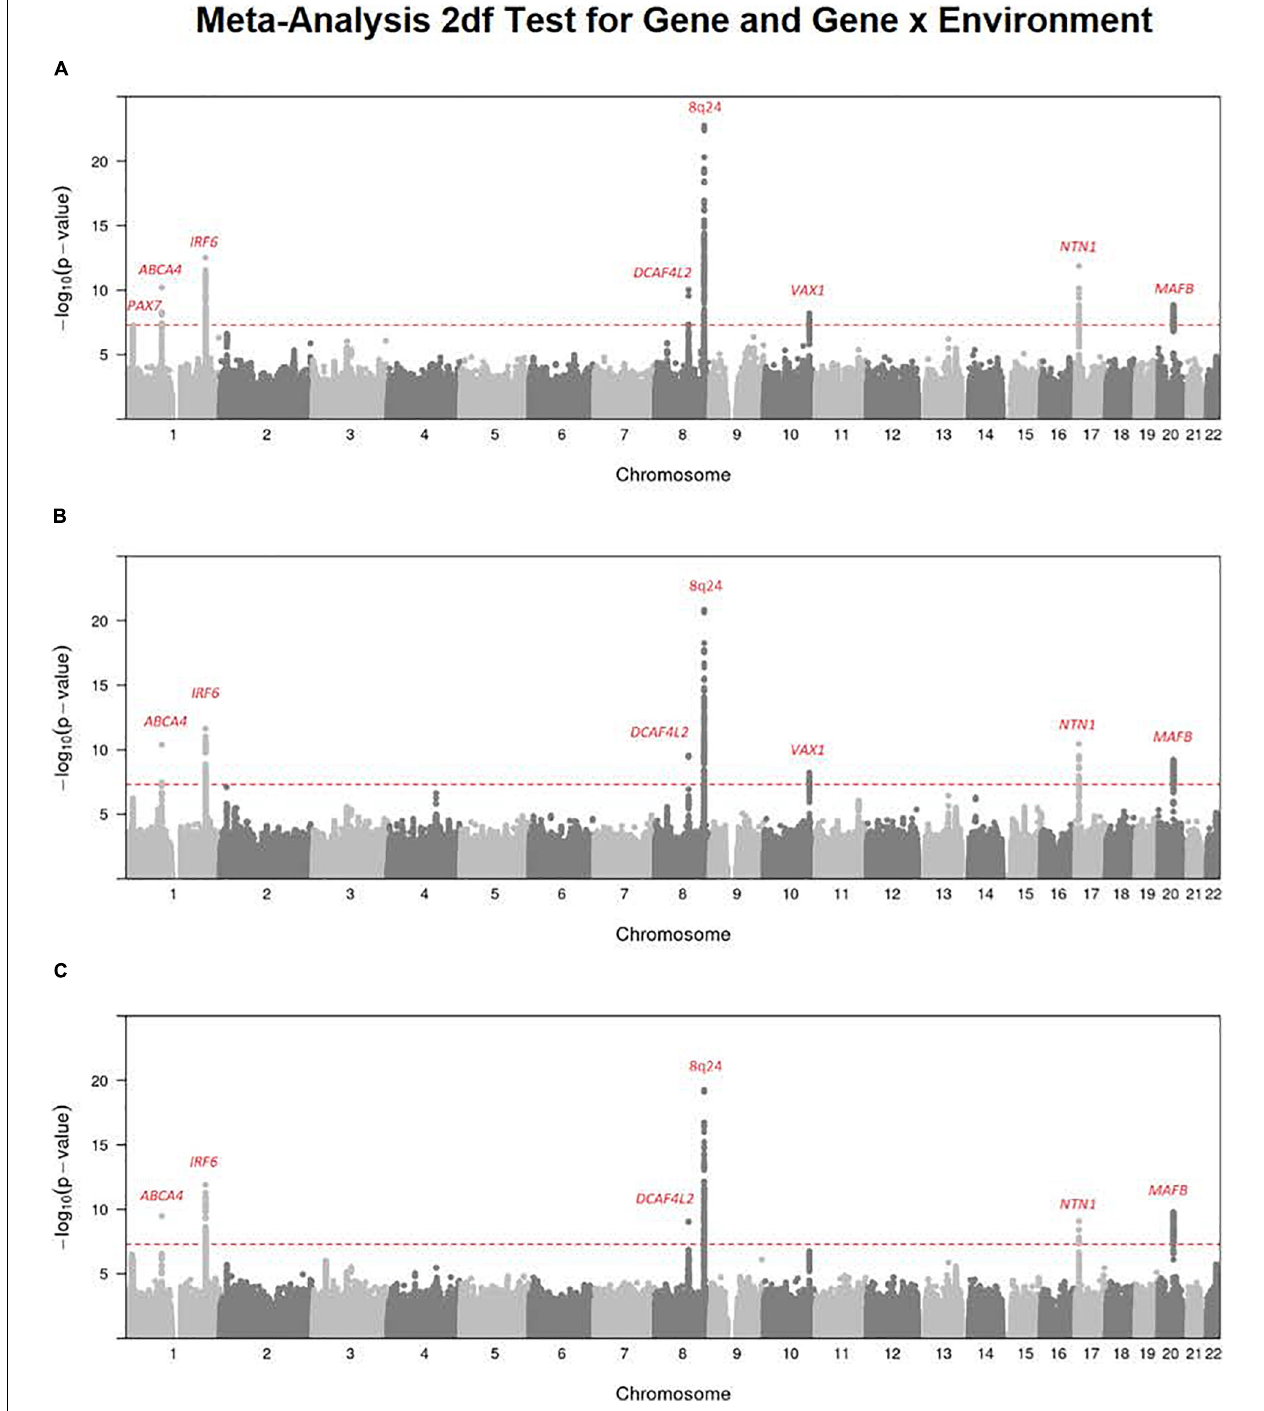
FIGURE 1 | Meta-analysis of the 2 df joint test for G and G × E interaction on all OFC case–parent trios across both the GENEVA and POFC studies. Numerous genes/regions show strong evidence of influencing risk to OFC largely through the main gene effect ( β G ) with very subtle differences that could be attributed to G × E interaction effect ( β GE ). Most of these strong signals represent recognized risk genes for CL/P. (A) Meta-analysis of 2 df test for G and G × Smoking interaction. (B) Meta-analysis of the 2 df test for G and G × Alcohol interaction. (C) Meta-analysis of the 2 df test for G and G × Vitamin interaction. The red dashed line represents the conventional threshold for genome-wide significance (5 × 10 − 8